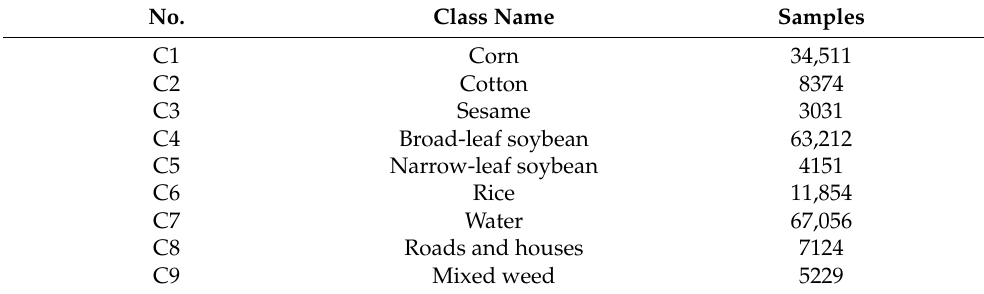
Figure 2. The LongKou dataset: ( a ) Hyperspectral image; ( b ) Ground truth; ( c ) Typical crop photos in the study area. Table 1. Ground truth classes for the LongKou dataset and the corresponding sample